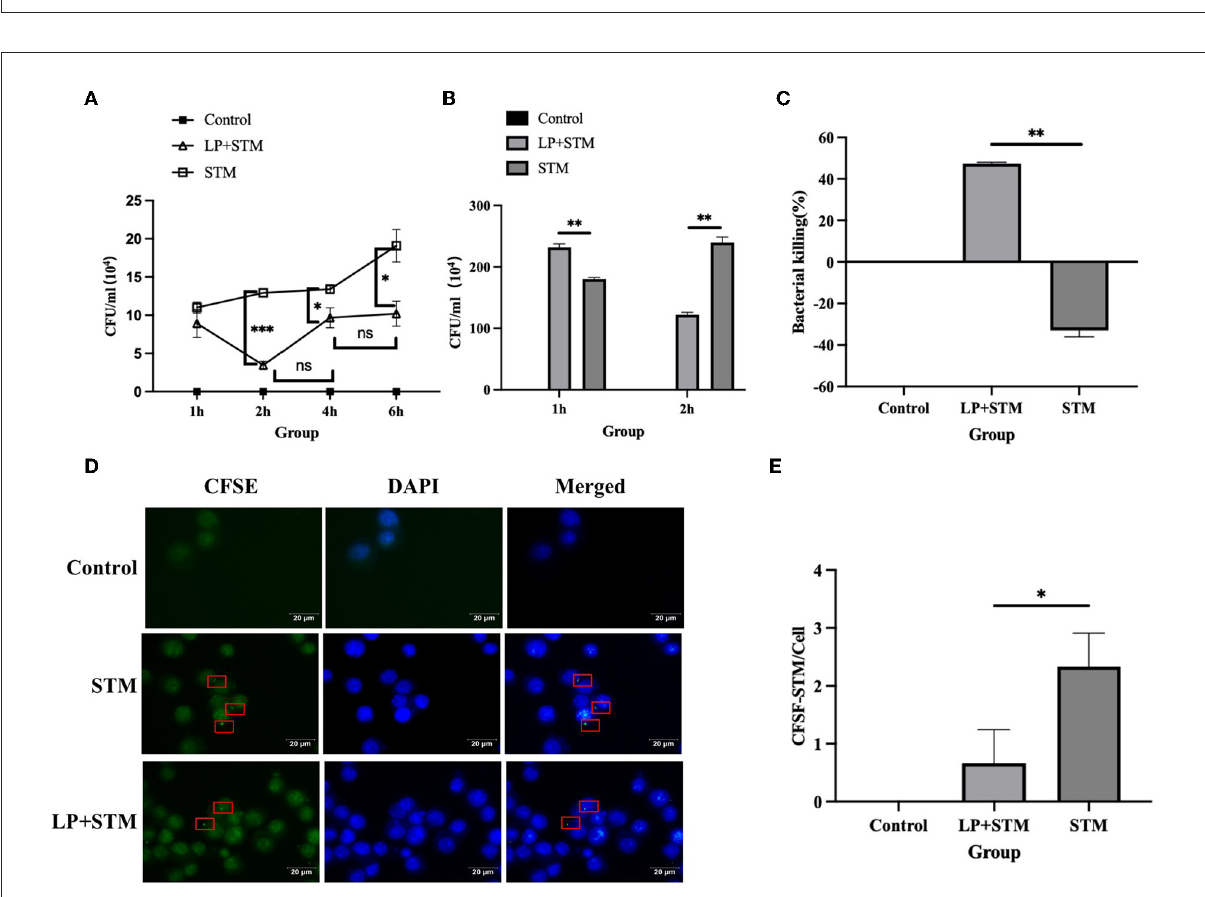
FIGURE2 LP enhanced the ability of RAW264.7 to phagocytosis and kill STM. (A) Intracellular STM counts in RAW 264.7. RAW 264.7 (5 × 10 5 cells/well) were pre-treated with LP (5 × 10 6 CFU/well) or PBS for 1h and then infected by STM (5 × 10 6 CFU/well) for 1h. After killing extracellular bacteria with gentamicin (50 µ g/ml) RPMI-1640 medium for 1h, cells incubated for 1, 2, 4, and 6h were lysed onto an SS agar plate. (B) The number of intracellular STM at 1h and 2h pi of STM infection. (C) Histogram of bactericidal activity. Bactericidal activity is calculated